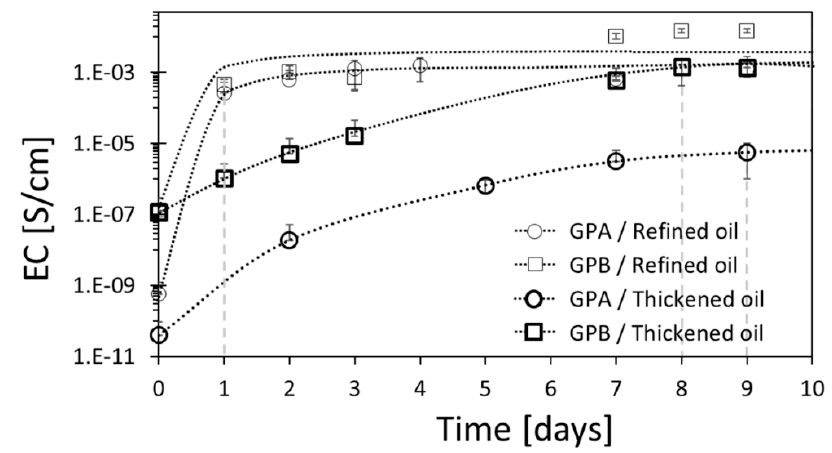
Figure 4. Temporal EC of refined and thickened linseed oils loaded with 25 wt% GPA or GPB upon exposure to air at 27 °C. The dashed lines denote the indication of air-exposure time (IAET) during which the composite ended the shrink-percolation process. The dotted lines are drawn as guidance for the eye.